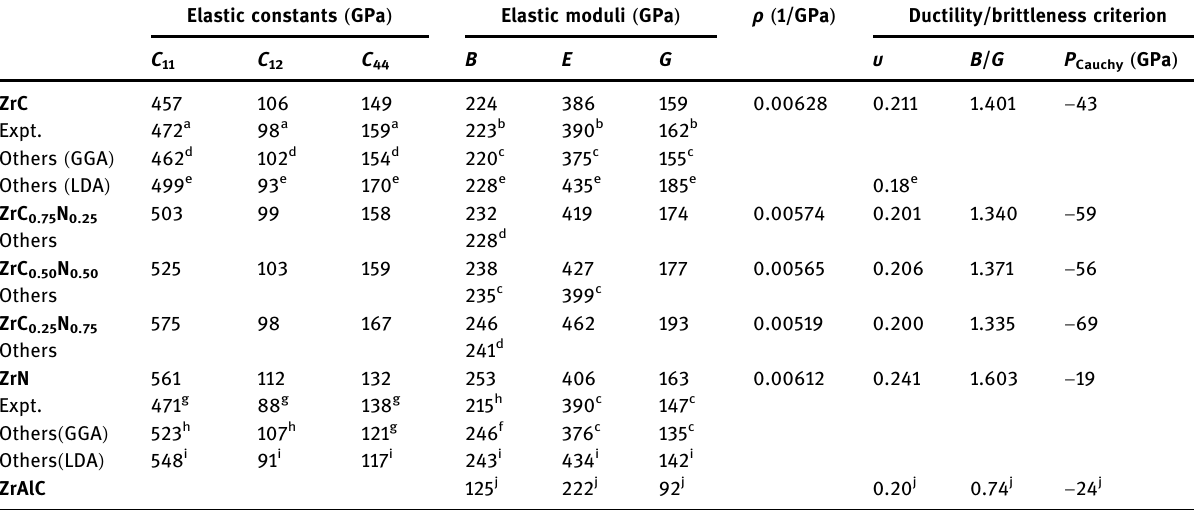
Table 2: Elastic constants ( C ij ) , elastic moduli ( B , E , G ) , compressibility ( ρ ) , and ductility/brittleness criteria for ZrC x N ( 1 − x ) Elastic constants ( GPa ) Elastic moduli ( GPa )